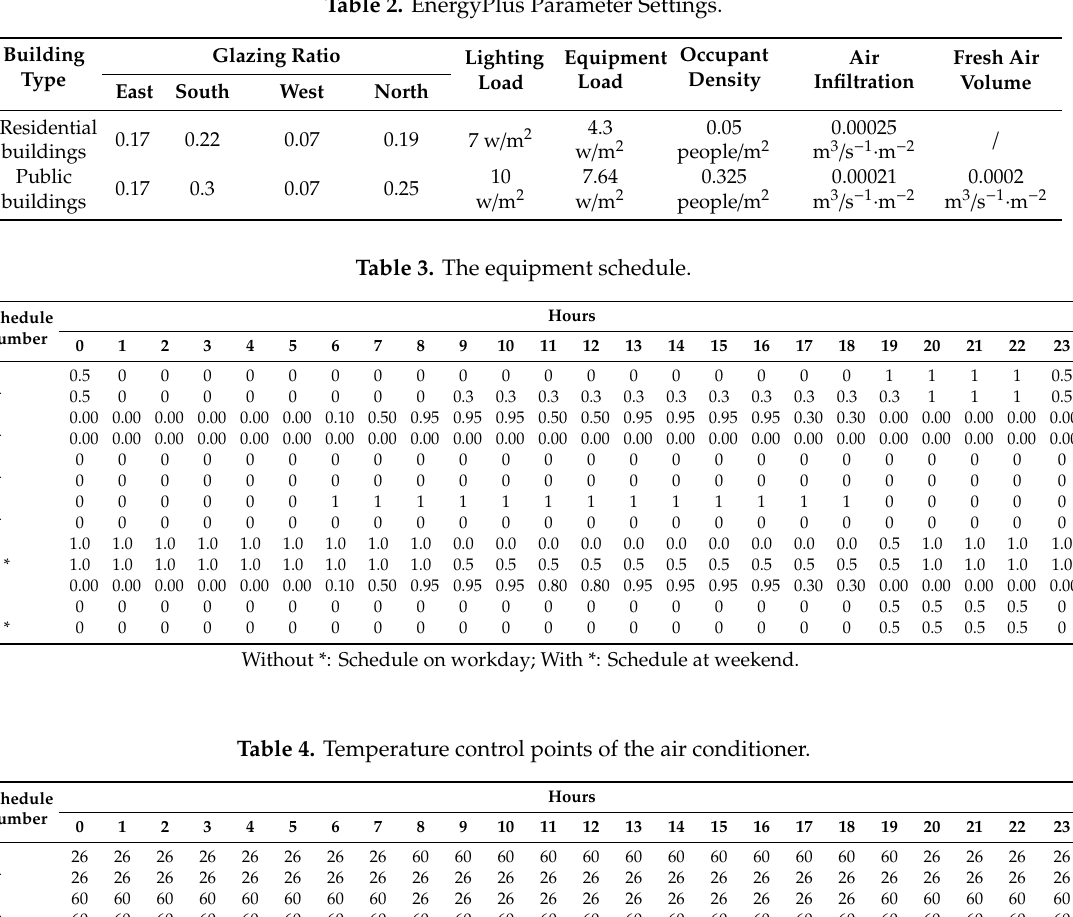
Table 2. EnergyPlus Parameter Settings.